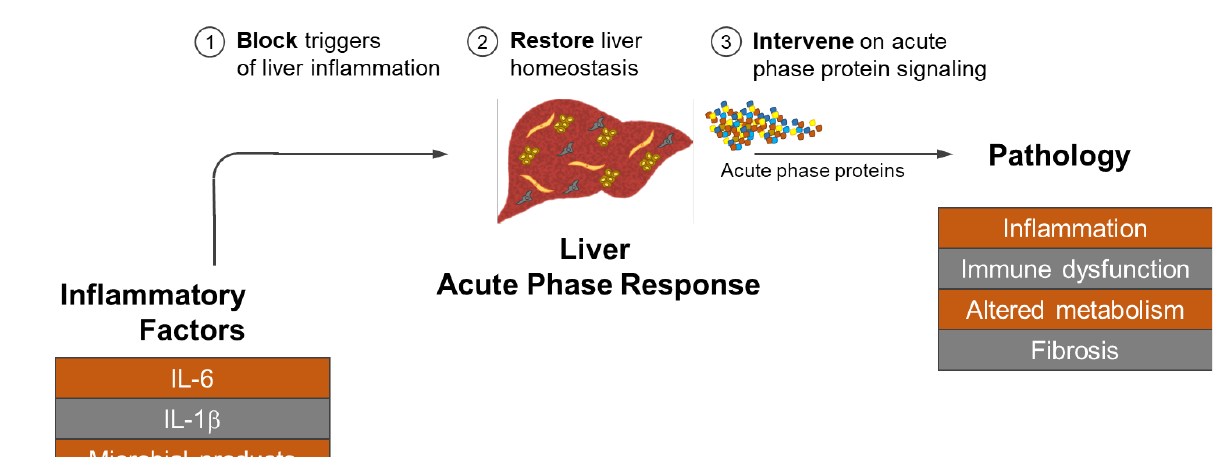
Figure 3. Strategies for intervening on the liver acute phase response in cancer. Inflammatory factors including IL-6, IL-1 β , and microbial products (e.g., LPS) trigger the acute phase response in the liver leading to the release of acute phase proteins by activated hepatocytes, hepatic stellate cells, endothelial cells, and myeloid cells. Chronic release of acute phase proteins then mediate pathology by supporting inflammation, immune dysfunction (e.g., T cell apoptosis), alterations in metabolism (e.g., iron metabolism), and fibrosis. Shown are three potential approaches to intervene on the liver acute phase response by (1) blocking the activity of inflammatory factors that trigger liver inflammation (e.g., with blocking antibodies against IL-6), (2) restoring liver homeostasis by provoking a restorative immune response or disrupting the release of acute phase proteins by liver resident cells (e.g., via STAT3 inhibition), and (3) intervening on acute phase protein signaling by neutralizing acute phase proteins or inhibiting their interaction with downstream receptors (e.g., with TLR inhibitors).